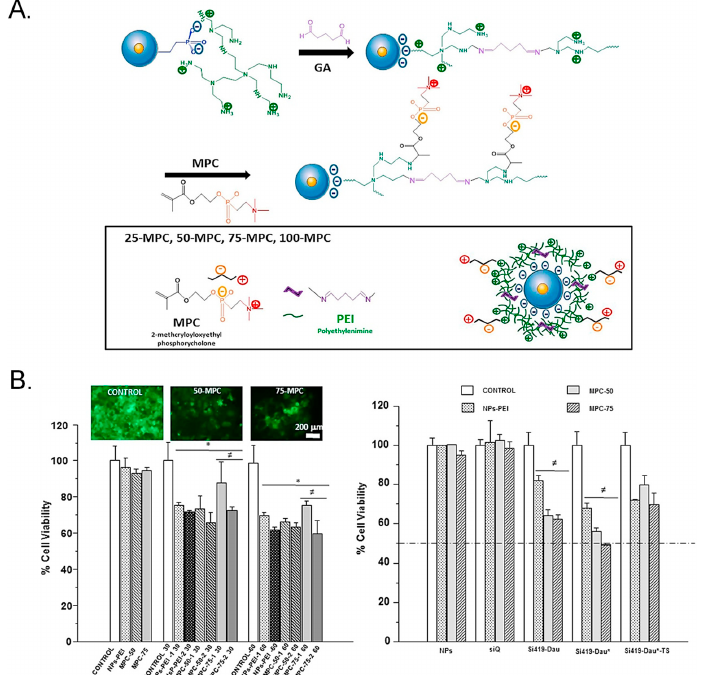
Figure 1. ( A ) Schematic representation of the mesoporous silica nanoparticles (MSNs). MSNs were functionalized with PEI for siRNA loading and further modified with a phosphorylcholine derivative